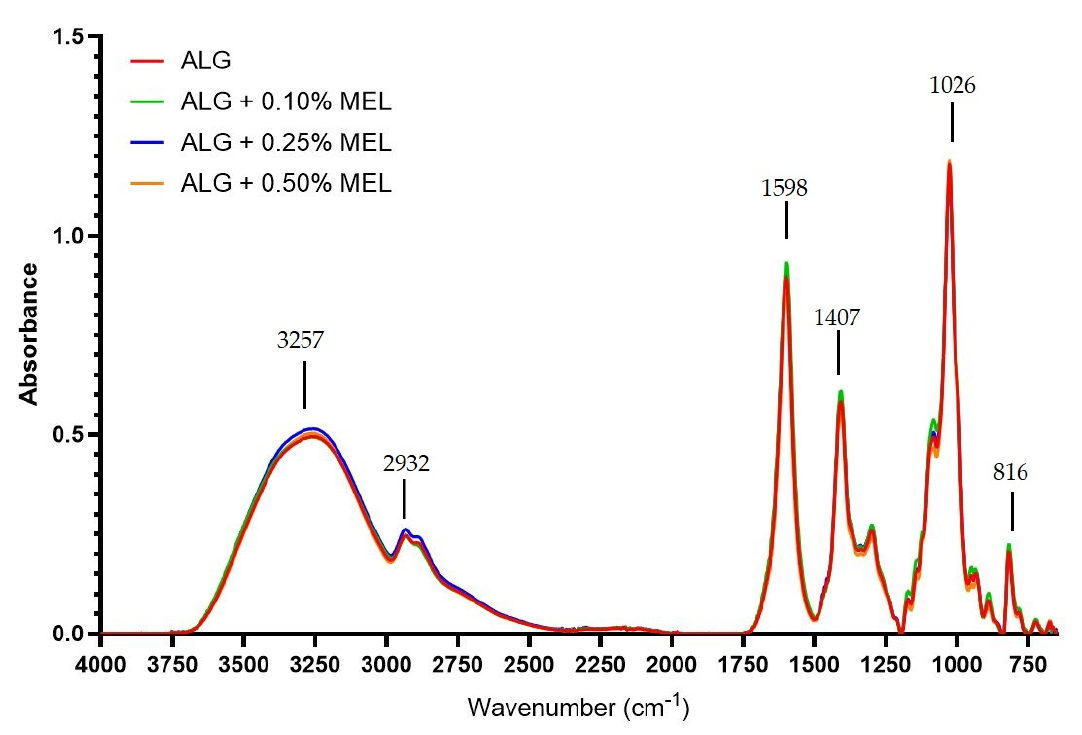
Figure 6. FT-IR spectra of unmodified and modified with melanin alginate films.